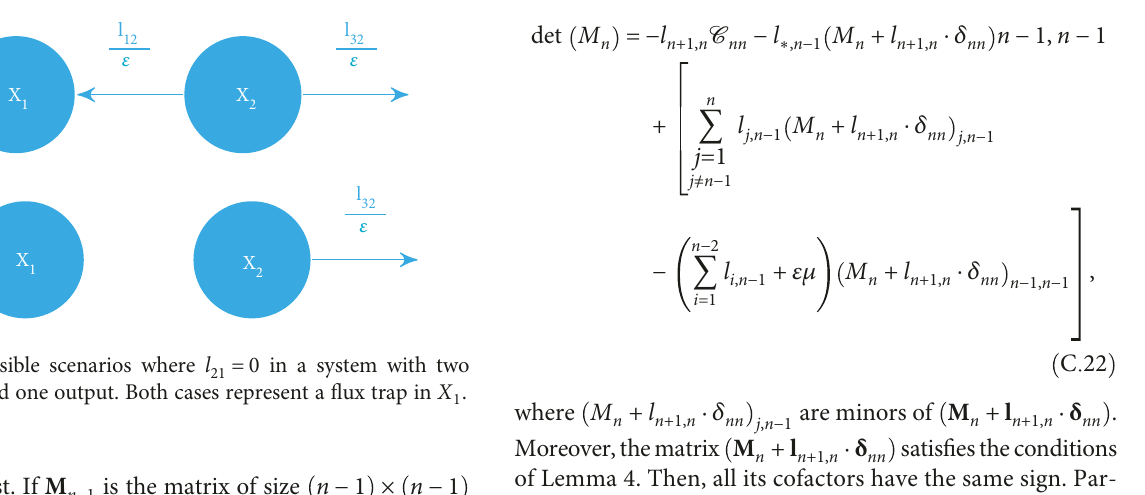
= 0 in a system with two 21 1